Question: Write a single sentence explaining what this figure depicts.
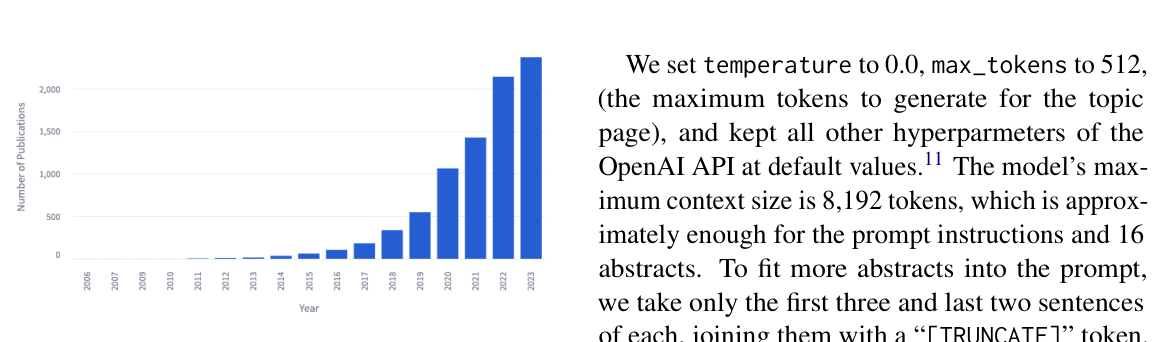
Answer: Example publications per year histogram dis- played to users for the entity: “Microplastics”.